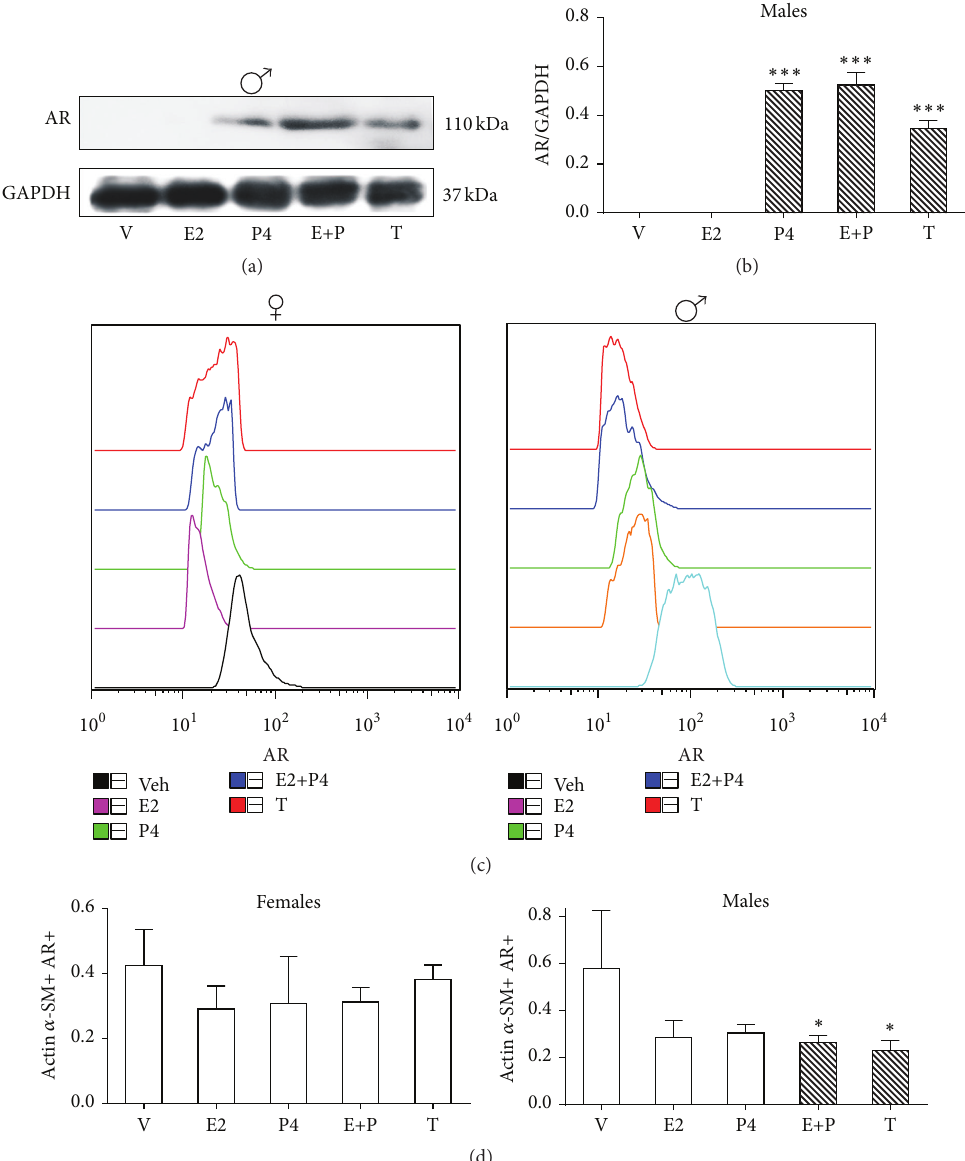
Figure 4: Regulation of AR protein content by sex hormones in airway smooth muscle (ASM) and airway smooth muscle cells (ASMC). AR protein content in ASM and ASMC of gonadectomized female and male rats were treated as described in Figure 1 legend. (a) A representative assayoffourWesternblotexperimentsisshown(detailsaredescribedinFigure1legend).(b)ProteinsdetectedbyWesternblotwerequantified by densitometric analysis and corrected by GAPDH protein content. Results are expressed as mean ± SD, 𝑛 = 4 . ∗∗∗ 𝑝 < 0.001 compared with vehicle treatment. (c) Flow cytometry histogram plots are based on forward scatter (FSC) and side scatter (SSC) gating for ASMC. This was validated using actin 𝛼 -smooth muscle and AR staining. A representative example of the gating strategy is shown. (d) Geometric mean fluorescence intensity (gMFI) for AR expression on ASMC. Results are expressed as mean ± SD, 𝑛 = 4 . ∗ 𝑝 < 0.05 compared with vehicle treatment. Results are expressed as mean ± SD, 𝑛 = 4 . ∗ 𝑝 < 0.05 compared with vehicle